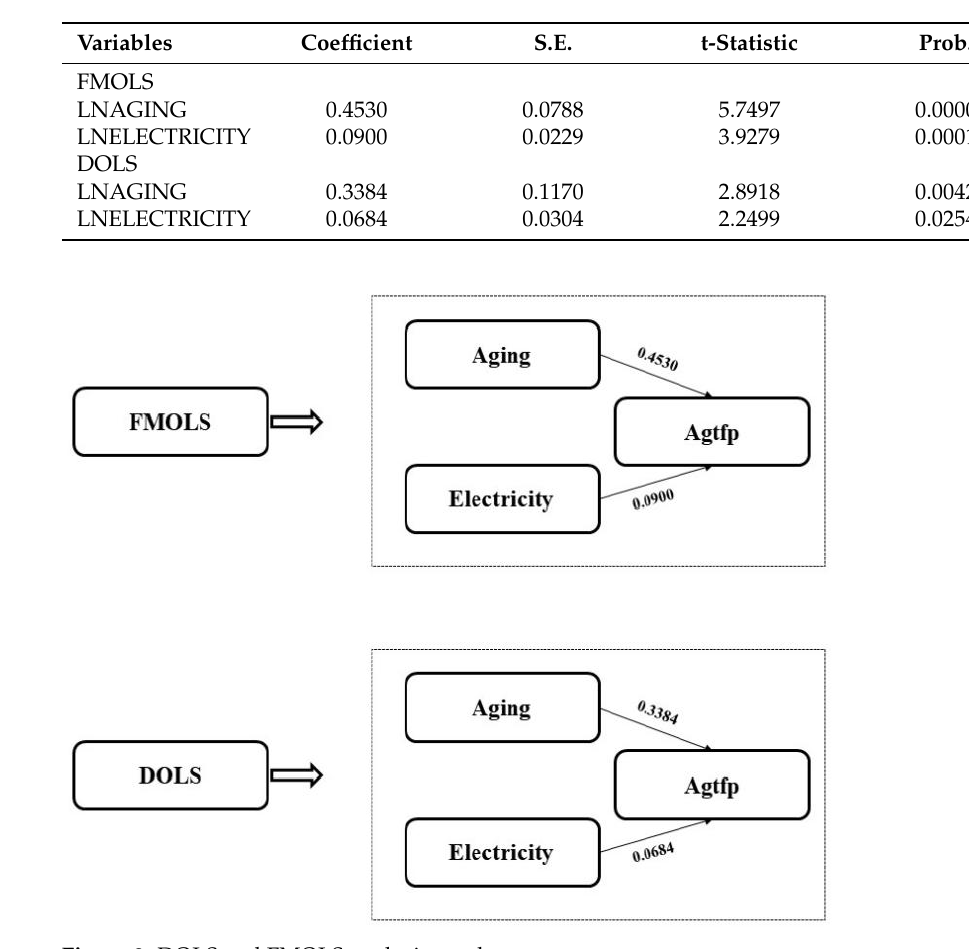
Figure 3. DOLS and FMOLS analysis results.